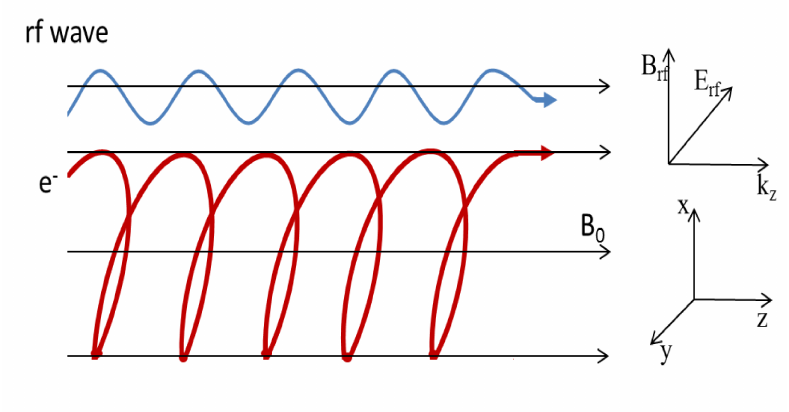
Figure 6. Geometry of the CARM